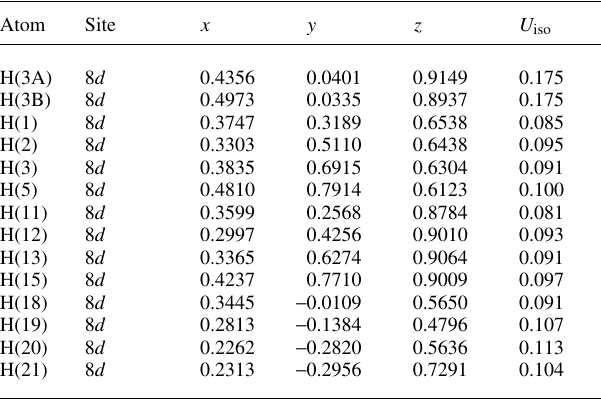
Table 2. Atomic coordinates and displacement parameters (in Å 2 )